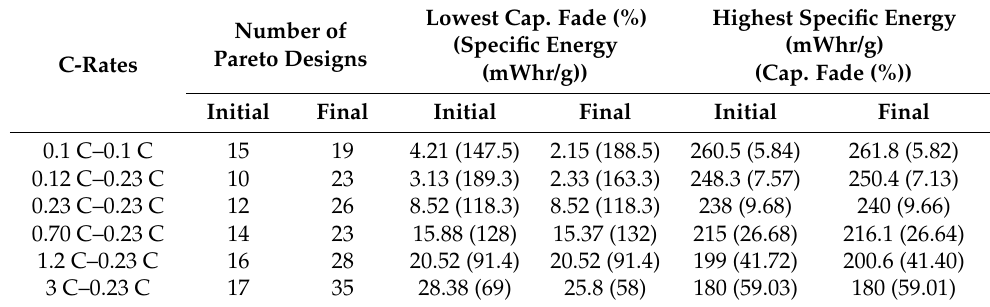
Table 3. Comparison between initial and final Pareto designs.